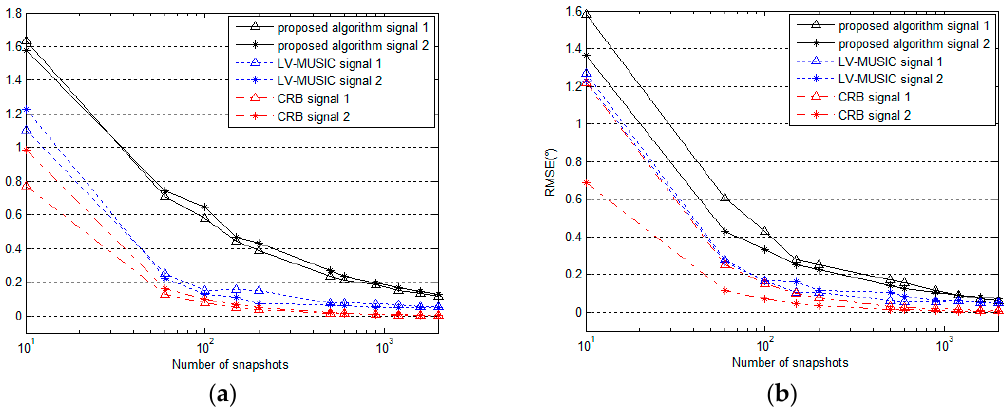
Figure 10. RMSE of ( a ) azimuth angle and ( b ) elevation angle estimation versus number of snapshots (for SNR = 20 dB).